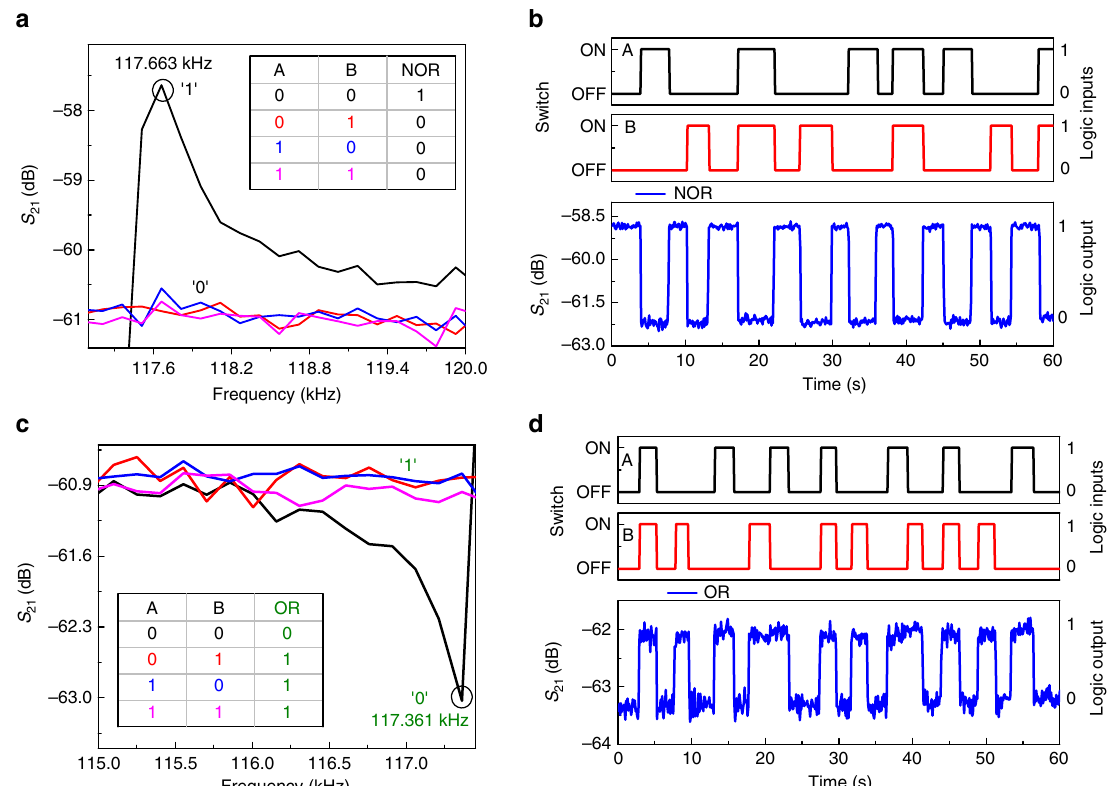
Figure 4 | Demonstration of 2-bit NOR and OR logic gates. ( a ) Frequency responses of the resonator for different logic input conditions where (0,0) logic input condition, shown in black has high S 21 transmission signal at 117.663kHz and others have low S 21 transmission signal represented by 1 and 0, respectively. Truth table of NOR logic output is shown in the inset. ( b ) Demonstration of NOR logic operation when the frequency of the a.c. input signal is chosen as 117.663kHz. Two input signals A and B are shown in black and red, respectively, where the switch OFF/ON corresponds to 0/1 logic input conditions. The S 21 transmission signal in blue corresponds to the logic output and fulfills the NOR truth table. ( c ) Frequency responses of the resonator for different logic input conditions, where (0,0) logic input condition shown in black has low S 21 transmission signal at 117.361kHz and others have high S 21 transmission signal, represented by 0 and 1, respectively. Truth table for OR logic output shown in the inset. ( d ) Demonstration of OR logic operation when the a.c. input signal frequency is chosen as 117.361kHz. Two input signals, A and B are shown in black and red, respectively, and the switch OFF/ON corresponds to 0/1 logic input conditions. The S 21 transmission signal in blue corresponds to the logic output that fulfills the OR truth table.